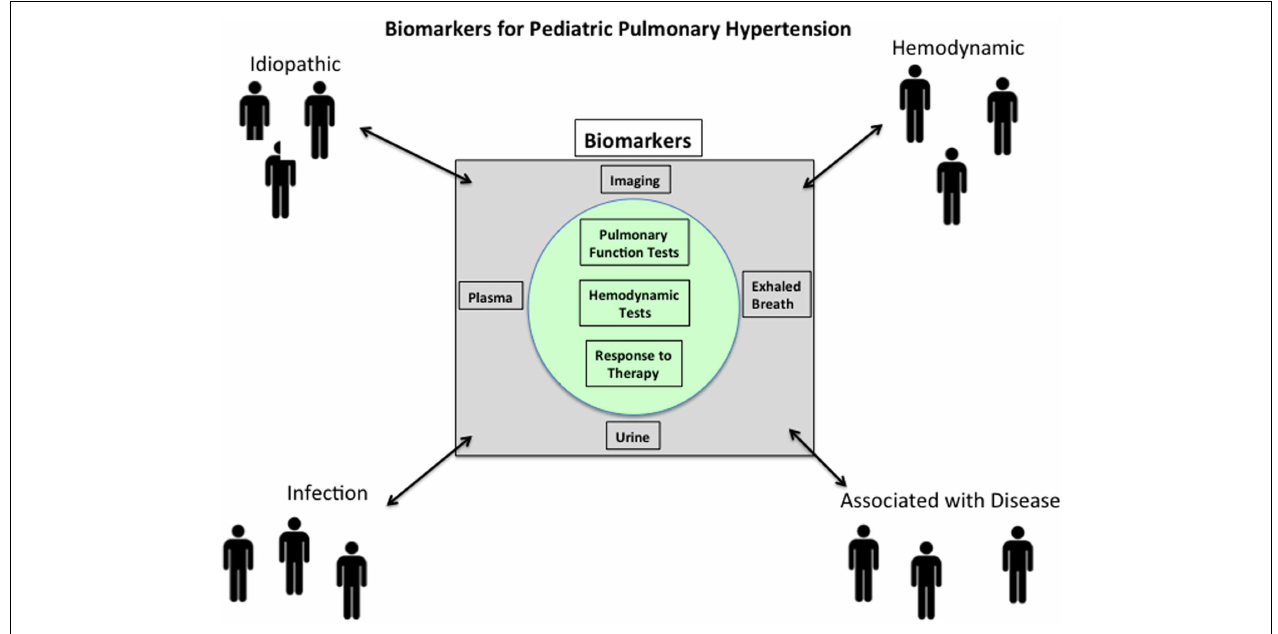
pulmonary vascular resistance, etc., and/or to a clinical measurement such as survival, pulmonary function test, etc. Since the pathobiology of PAH is multifactorial and complex, it should not be surprising that potential biomarkers will likely reflect aspects of the underlying disease